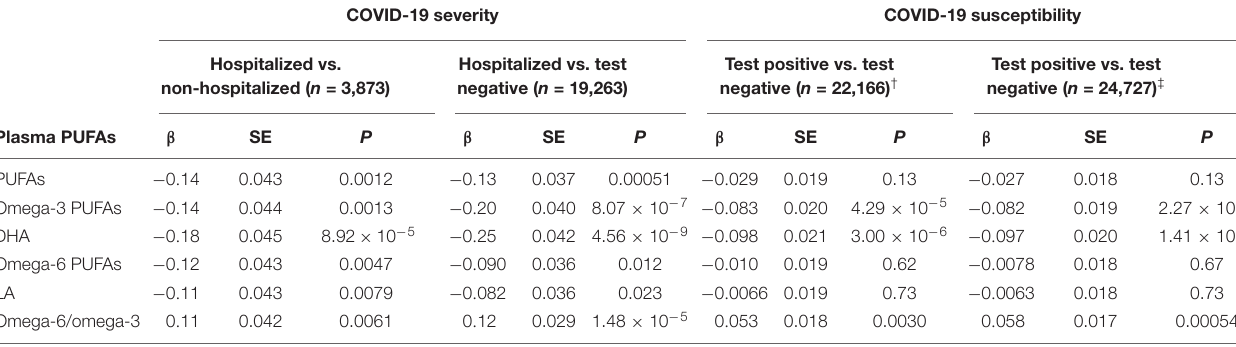
TABLE 2 | Associations of single polyunsaturated fatty acids (PUFAs) with COVID-19 susceptibility and severity.* COVID-19 severity